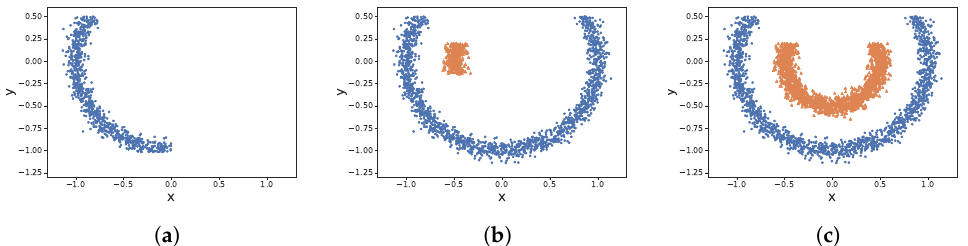
Figure 9. Validation of the Macro SOStream create function with the Horseshoe dataset. ( a ) Clustering of the first 800 samples. ( b ) Clustering of the first 1950 samples. ( c ) Final result, where different colors represent different